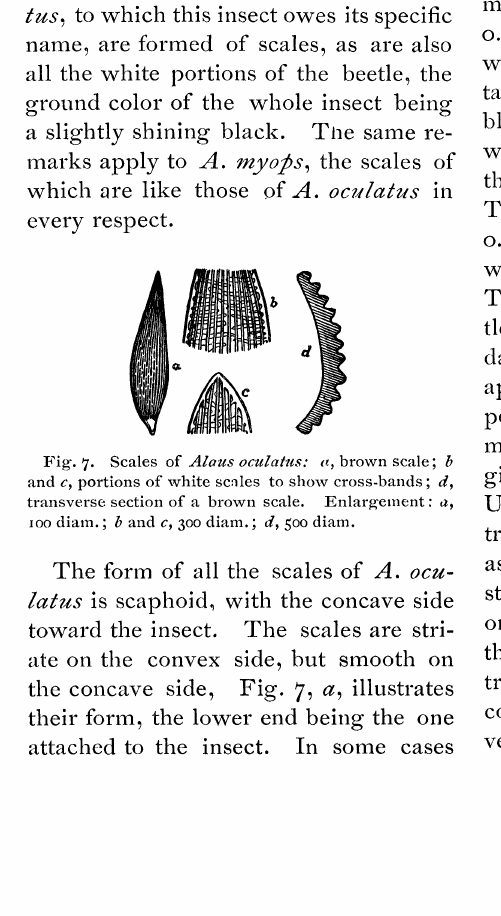
Fig. 7. Scales of Alaus oculalus: a, brown scale; and c, portions of white scales to show cross-bands; d, transverse section of brown scale. Enlargement: a, diam. and c, 30o diam. d, oo